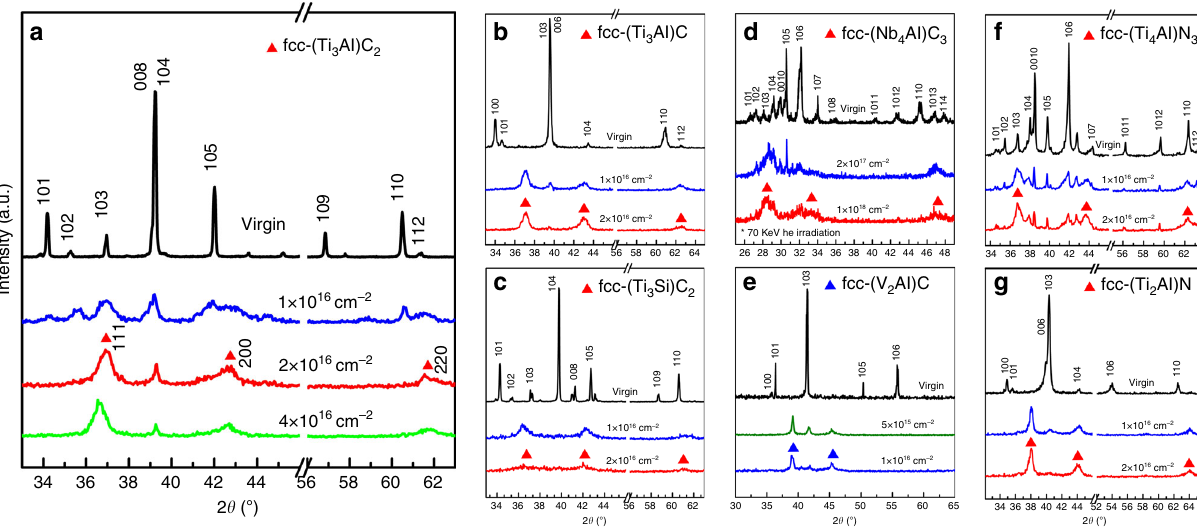
Fig. 4 Formation of fcc structural solid solutions in seven MAX phases. Grazing incidence X-ray diffraction patterns of Ti 3 AlC 2 ( a ), Ti 2 AlC ( b ), Ti 3 SiC 2 ( c ), Nb 4 AlC 3 ( d ), V 2 AlC ( e ), Ti 4 AlN 3 ( f ), and Ti 2 AlN ( g ), respectively. Nb 4 AlC 3 was irradiated with 70 KeV He ions and the rest were irradiated with 1 MeV Au ions. There emerge three new diffraction peaks (111, 200, and 220) characteristic of the fcc phases following irradiation, which are indicated by triangles. This indicates that all of these compounds transform from the initial hexagonal structures to fcc structures. The peak positions of the fcc structures are all slightly different from those of their corresponding binary MX